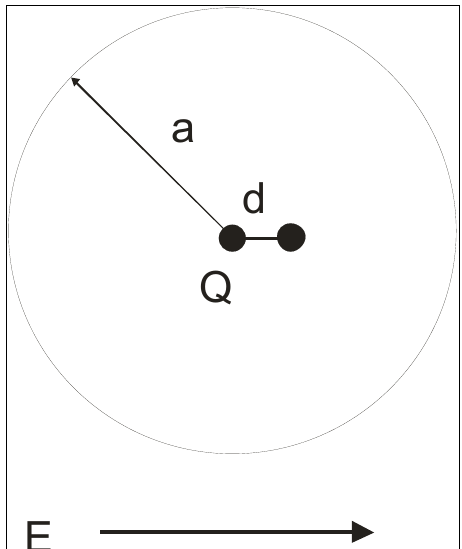
Figure 3. Atom in an external electric